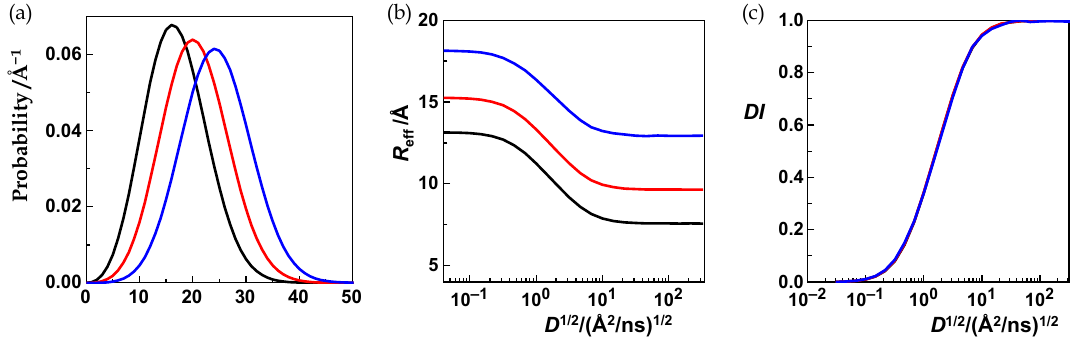
Figure 3. ( a ) Three different 3-D Gaussian distance distributions (black, red, blue). ( b ) The corre- sponding diffusion profiles (black, red, blue) with the effective distance plotted against the square root of the diffusion coefficient. The donor lifetime, the Förster radius, and the left integration limit were kept constant ( 𝜏 D = 100 ns, R 0 = 10 Å, r L = 2.5 Å) ( c ) After normalization (Equation (11)), the three profiles became identical.